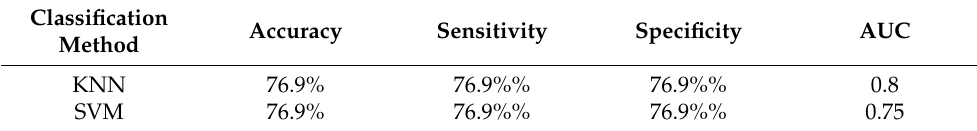
Table 5. Evaluation of classification performance for O2 channel.